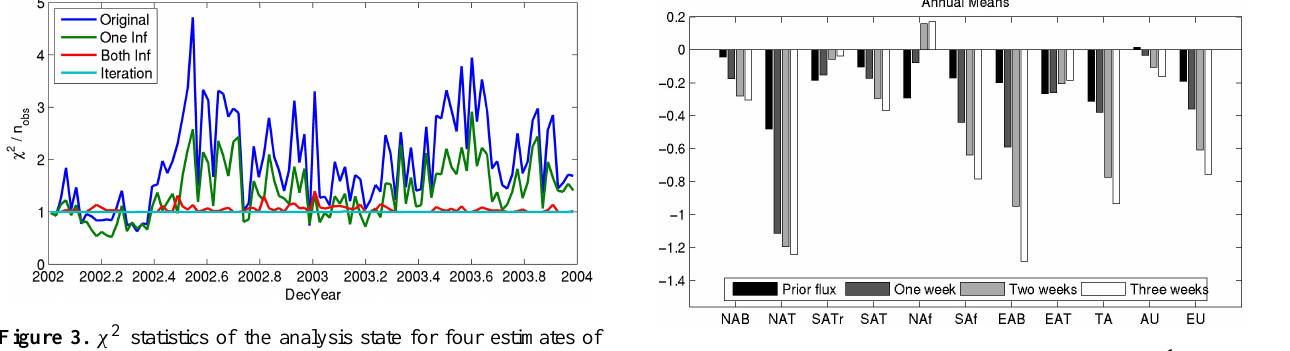
Figure 4. Annual means of carbon budgets (PgCyr − 1 ) on 11 Transcom regions in four different cases. Four cases are associated with prior values modeled with ecosystem model BEPS, assimi- lated results using GCAS-EK with 1-week assimilation windows, 2-week windows and 3-week windows. In all, 11 regions in x axis refer to North American boreal (NAB), North American temperate (NAT), South American tropical (SATr), South American temperate (SAT), northern Africa (NAf), southern Africa (SAf), Eurasia bo- real (EAB), Eurasia temperate (EAT), tropical Asia (TA), Australia (AU) and Europe (EU),